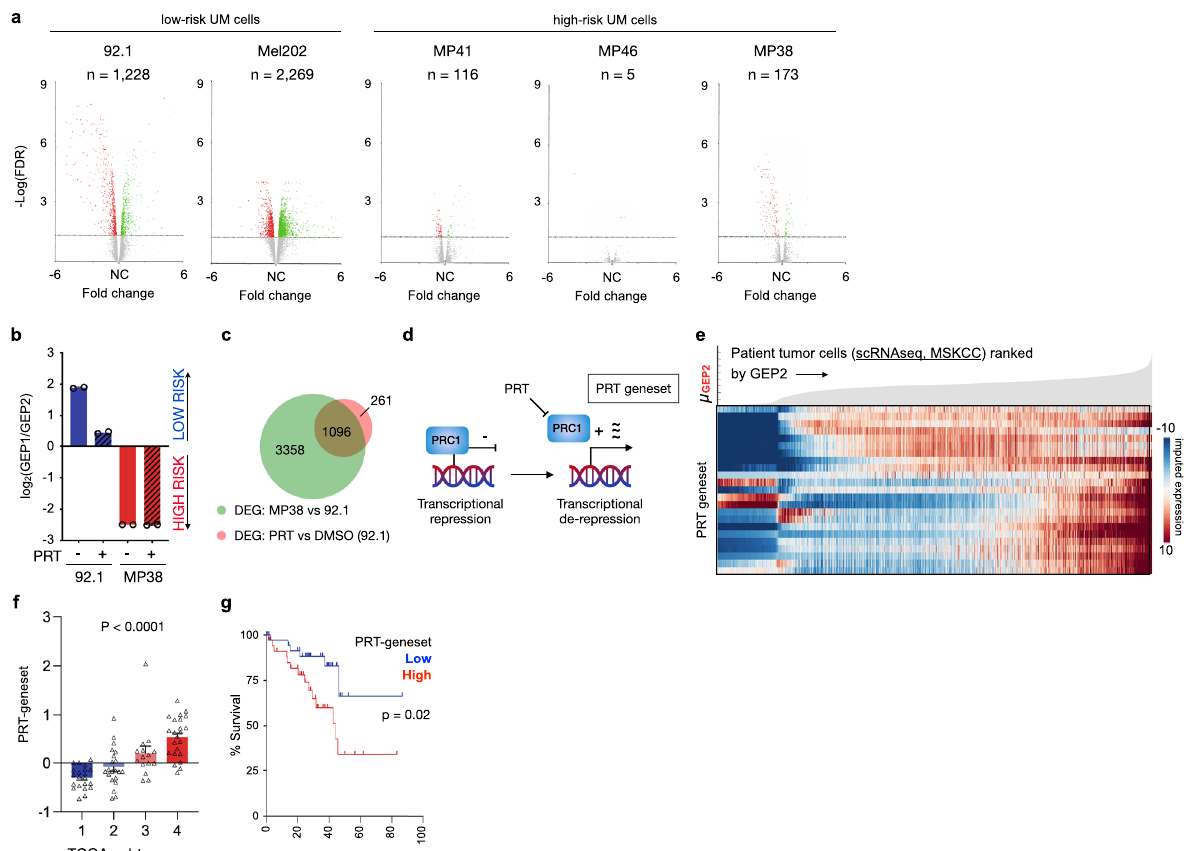
Fig. 3 Evolution of aggressive UM phenotype triggered by PRC1 inhibition. a Volcano plots showing differentially expressed genes upon PRT-treatment across fi ve UM cell lines ranked according to their GEP1/GEP2 score (see Supplementary Fig. 5a – c). Fold change for individual genes is shown as a function of signi fi cance, -log 10 (FDR). Genes with FDR value less than 0.05 and fold change greater or less than 1, were highlighted in green and red, respectively. Genes not meeting signi fi cance (FDR> 0.05) are shown as gray. Number of genes meeting signi fi cance (FDR<0.05) are annotated per each cell line. b Ratio of GEP1/GEP2 average gene signature expression (gene signatures annotated in Supplementary Data File 1) in low-risk UM cells (92.1) and high-risk UM cells (MP38) upon 24h DMSO or PRT-treatment; FPKM values obtained from bulk RNA-seq are reported (bar, mean; circles, biological duplicates). c Venn diagram of differentially expressed genes (DEG) upon PRT treatment (red) and between high-risk UM cells (MP38) and low-risk UM cells (92.1) (green). d A schematic showing transcriptional de-repression upon pharmacologic inhibition of PRC1 using PRT ( “ PRT-geneset ” annotated in Supplementary Data File 1). e Expression of the PRT-geneset across individual tumor cells ranked by average imputed expression of the GEP2 gene signature (gene signatures annotated in Supplementary Data File 1) in ascending order from left to right. For each gene, imputed expression was z-normalized across all cells and smoothed using a 20-cell moving average window. Top, fi lled area plot showing average expression of the GEP2 signature across ranked tumor cells. f Average expression of genes upregulated upon PRT-treatment of 92.1 cells ( ‘ PRT-geneset ’ ) across the 4 molecular TCGA subtypes. Statistical signi fi cance tested using one-way ANOVA; p = 9.6× 10 − 9 ; n = 80. Bars, mean of average expression; error bars, standard error of the mean. g Overall survival of ( n = 80) TCGA-UM patients with primary tumors strati fi ed by high (top 50th percentile, n = 40) and low (bottom 50th percentile, n = 40) average expression of the “ PRT-geneset ” . Statistical signi fi cance tested using two-sided log-rank